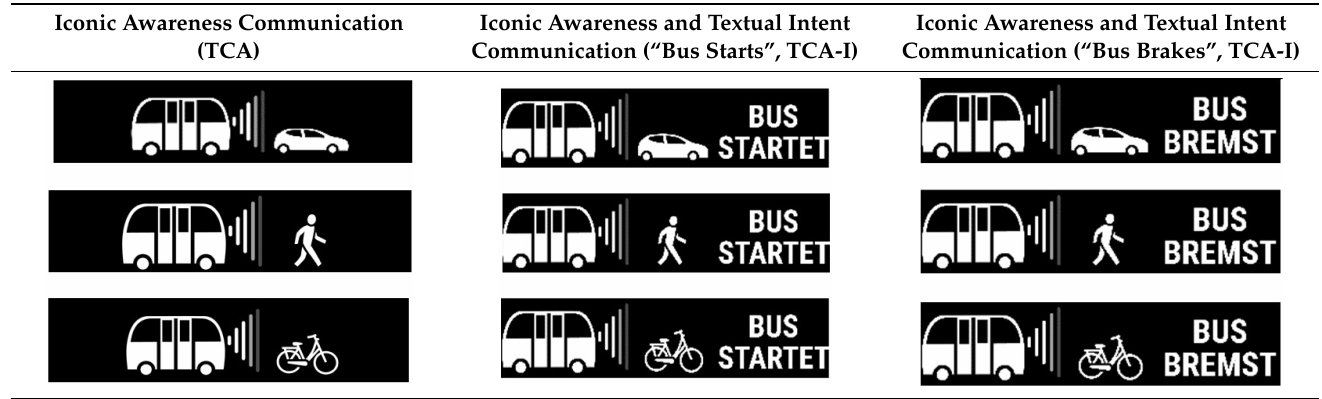
Table 1. Final external communication designs after expert